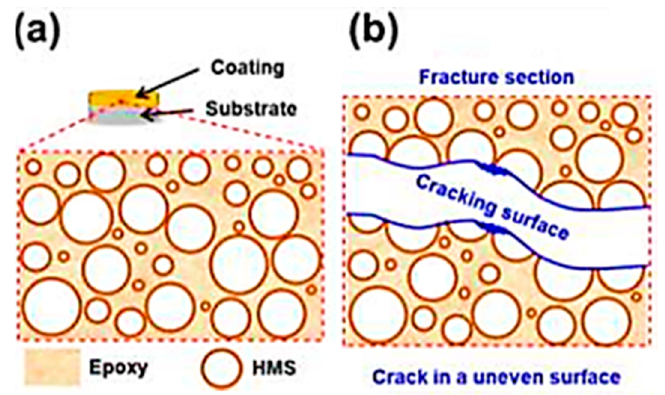
Figure 10. Schematic diagram of ( a ) original material and ( b ) tensile fracture surface after use in engine. HMS = phenolic resin hollow microspheres. Reprinted with permission from [124]. 2021, Elsevier.